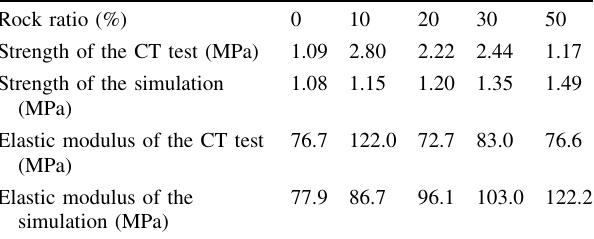
Table 3 Comparison between the numerical simulation results and the CT experiment